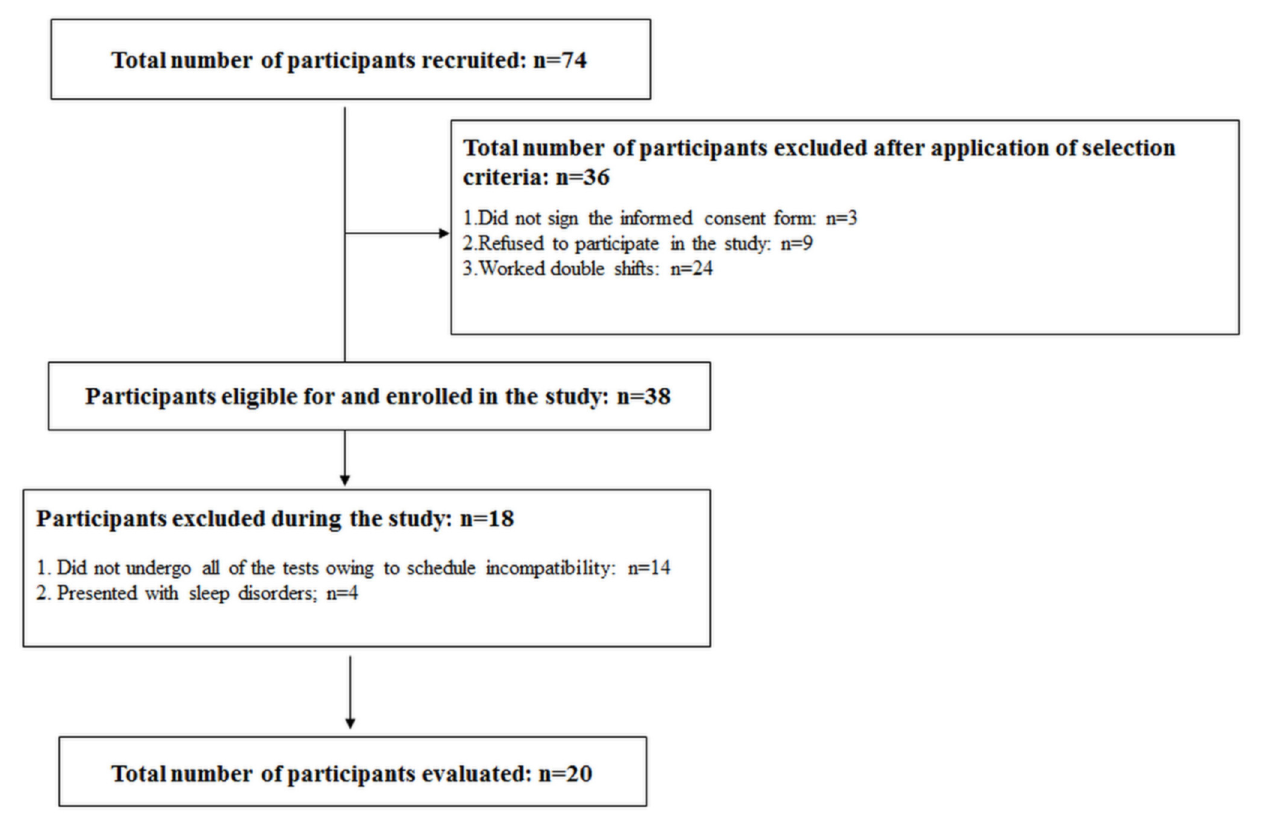
Fig 1. Flow chart of participation in this study.